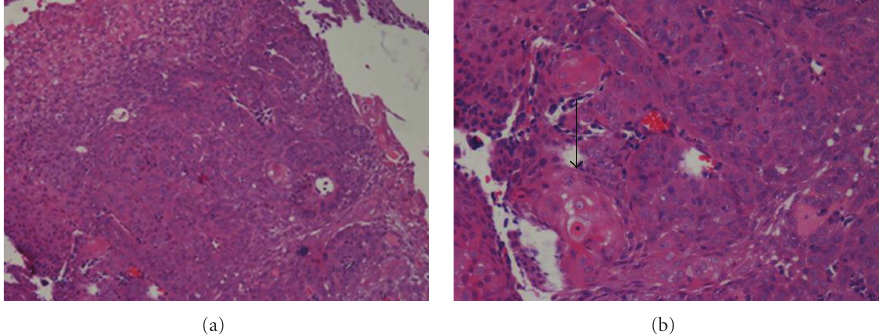
Figure 2: Micrographs of the squamous cell carcinoma of the gallbladder. (a) A liver biopsy showing squamous cell carcinoma with intermediate di ff erentiation under low power magnification (low power field), and (b) a squamatoid pearl (black arrow) under high power